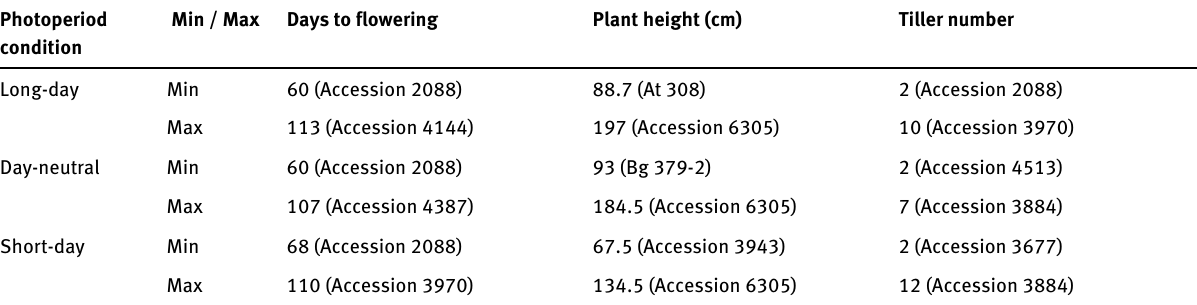
Table 2: Variation of days to flowering, plant height and tiller number under three photoperiods